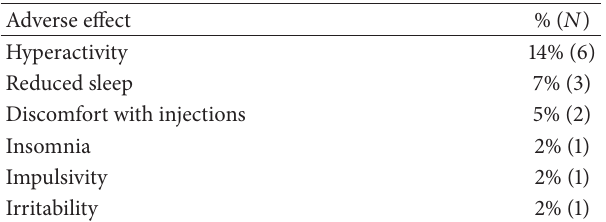
Table 3: Adverse effects reported of intervention with methylcobal- aminandfolinicacid.All44childrenwhoenteredthestudybutwere not lost to follow-up were